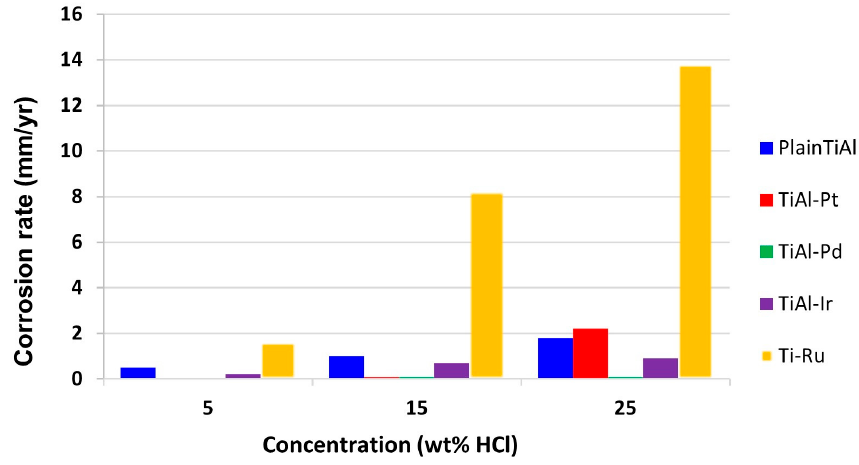
Figure 4. Corrosion rates of Ti-Al alloys with Pt-group metal additions in 5, 15, and 25 wt-%HCl solutions solutions [99].